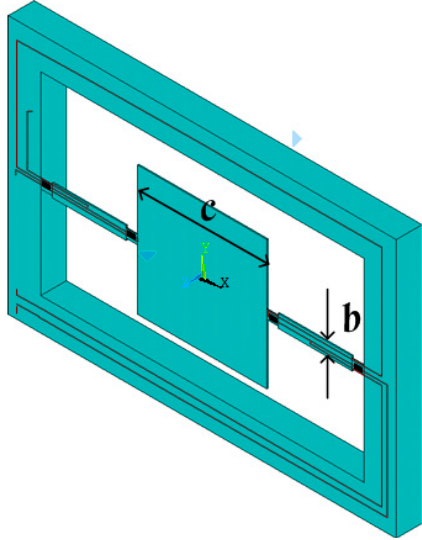
Figure 2. Sensitive microstructure of the MEMS electronic heart sound sensor. Sensors 2016 , 16 , 1728